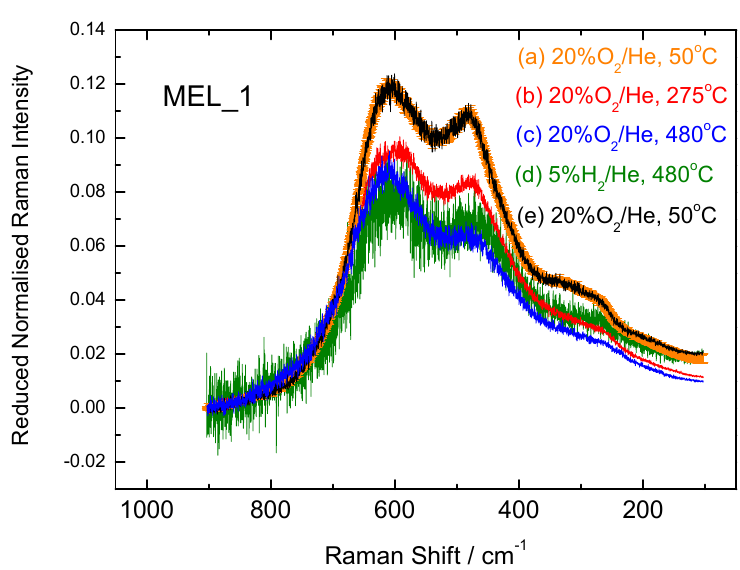
Figure 1. Evolution of in situ reduced and normalized sequential Raman spectra obtained for the MEL_1 material at ( a ) 50 °C under 20% O 2 /He after 2 h treatment at 450 °C, showing the standard deviation of five sequential recordings; ( b ) 275 °C under 20% O 2 /He; ( c ) 480 °C under 20% O 2 /He; ( d ) 480 °C under 5% H 2 /He; and ( e ) reinstatement at 50 °C under 20% O 2 /He after 30 min treatment at 480 °C. Laser wavelength, λ 0 = 491.5 nm; laser power, w = 15 mW; spectral slit width, ssw = 6 cm − 1 , time constant, τ = 1.0–1.3 s (see Section 3.2.2).